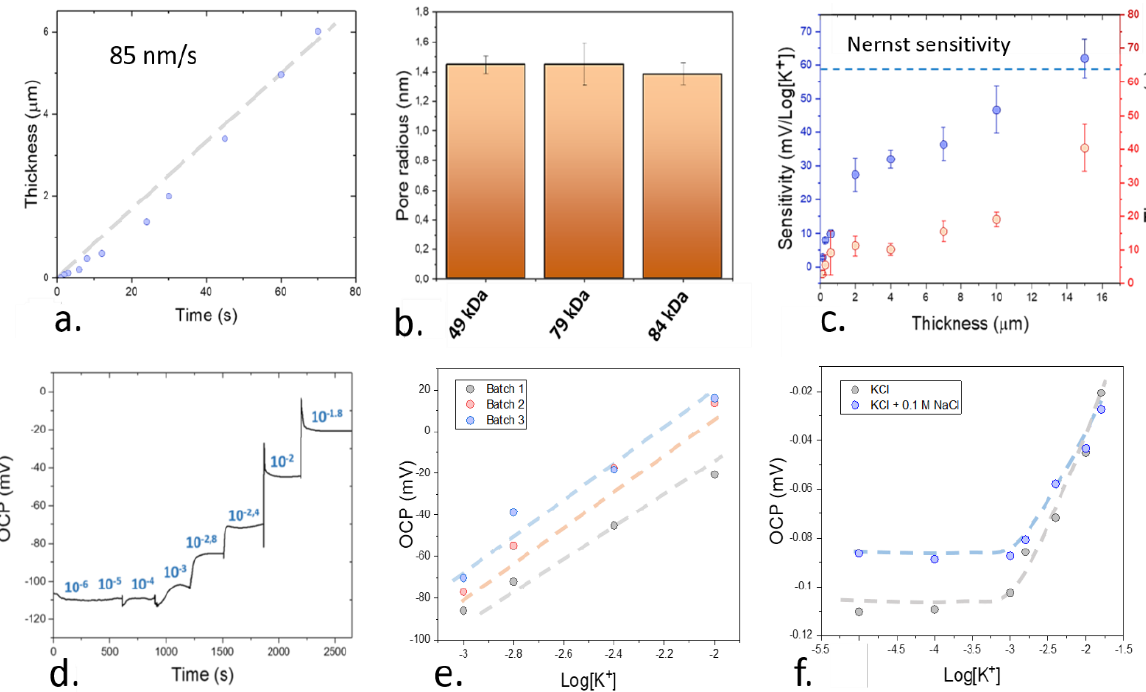
Figure 3. ( a ). Calibration of the film thickness using different deposition times by AACD. An increasing thickness was observed at higher deposition times as expected, allowing a fine control over the film dimensions. ( b ). Estimated pore size distribution of the low, medium and high molecular weight PVC films measured by Brunauer–Emmett–Teller (BET). ( c ) Changes in the sensitivity and response time of the sensing devices due to changes on the film thickness. The error bars represent the standard errors from the linear plot of the calibration. ( d ). Results obtained within a typical electrochemical characterization of an ion-selective electrode where the open circuit potential (OCP) of the working electrodes is monitored upon the use of different concentrations of electrolytes. ( e ) Testing of batch reproducibility by measuring the sensitivity of 3 different 15 µ m thick sensors. ( f ) Determination of the selectivity against Na + ions of the developed 15 µ m thick sensing devices by the fixed interference method.